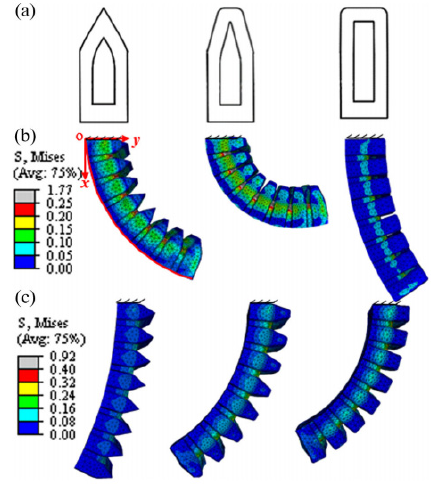
Figure 11. FEA model of a soft robotic actuator compared to experiment [123]. ( a ) Schematic of the chamber shape, ( b ) The maximum bending angles of the three actuators when deflated, ( c ) The FEA results of the three actuators at pressurization state (20 kPa). (Open Access).